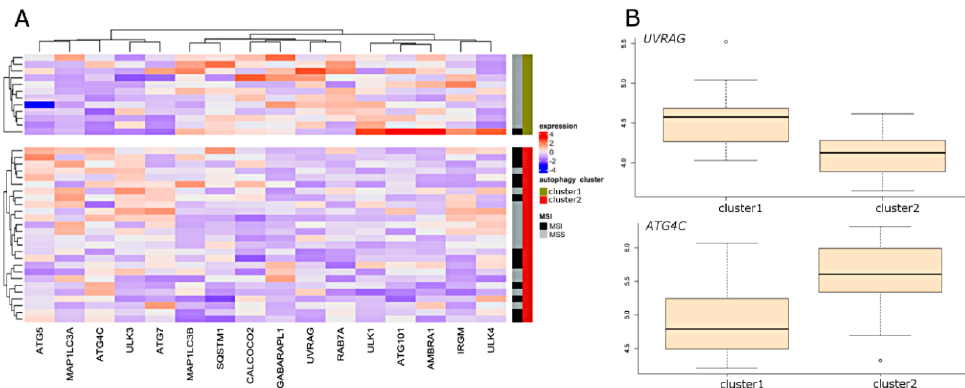
Figure 2. Results of unsupervised clustering and sPLS-DA in cell line dataset using selected autophagy-related genes. ( A ) Samples were separated based on unsupervised clustering and visualized genes were selected according to sPLS-DA. ( B ) The corresponding box plots illustrate the most highly ranked genes in terms of separation of clusters. MSI: microsatellite instability; MSS: microsatellite stability.